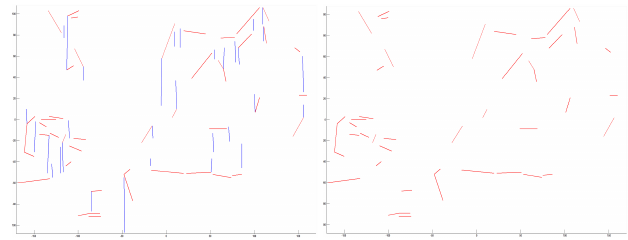
Figure 1. Refining lines. Top left : input capture. Top right : original lines. Bottom left : extracted compositions of lines based on geometric constraints. Bottom right : refined lines. Through geometric constraints of structured configuration and orientation, it is possible to refine lines, which is more efficient for estimating VPs.